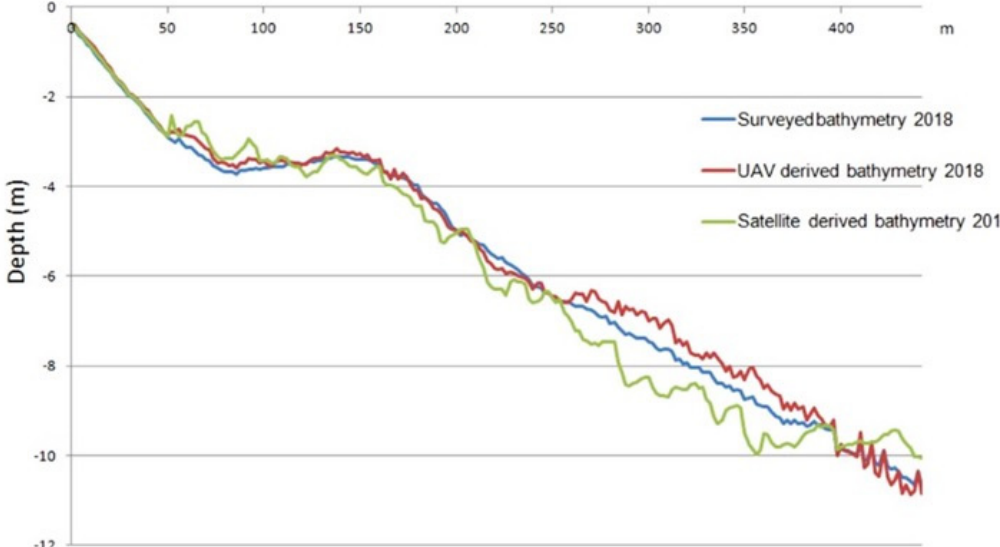
Figure 11. SDB and UDB (Stumpf’s model) compared to a real surveyed profile, perpendicular to the shoreline and located in the center of the study area.